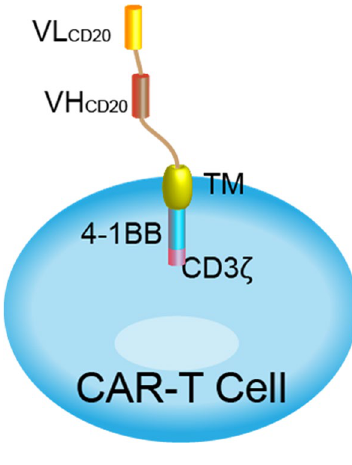
Fig. 1 Structure and charac- teristics of CAR-T20. CAR-20 is a 4 - 1BB/CD3-ζ-costimulated CAR-T targeted at CD20, and it is modified by LV2159K lenti- viral vector